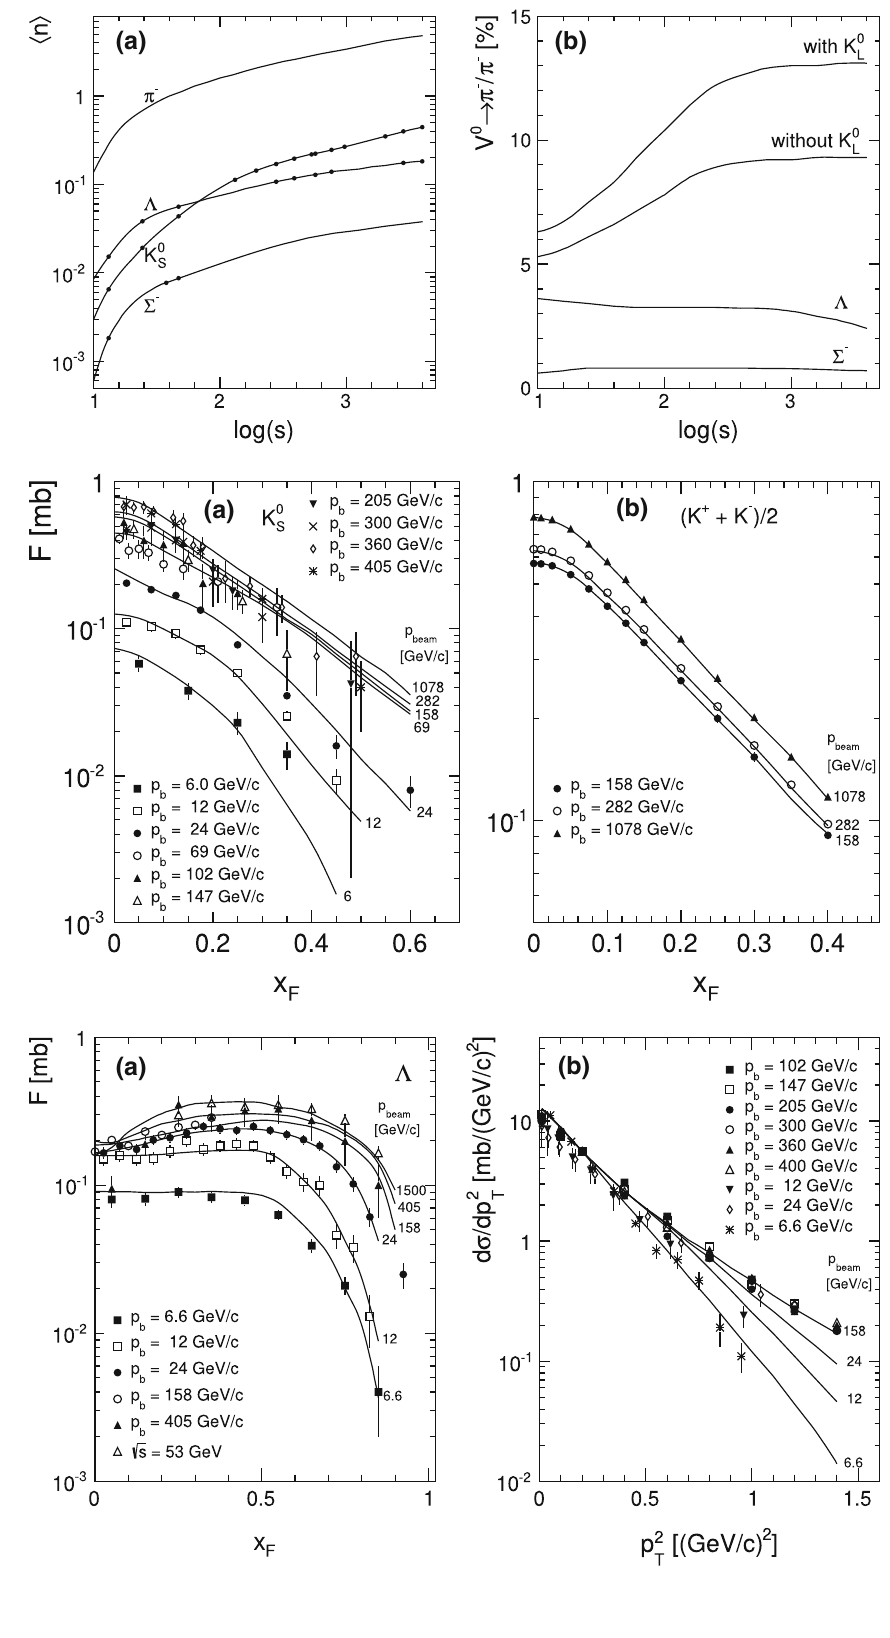
Fig. 8 a Total yields (cid:4) n (cid:5) of K 0 , S Λ and Σ − as a function of log s , in comparison to π − without feed-down correction; b percentage contribution of V 0 decays to the π − yield with and without K 0 and from Λ and Σ − L